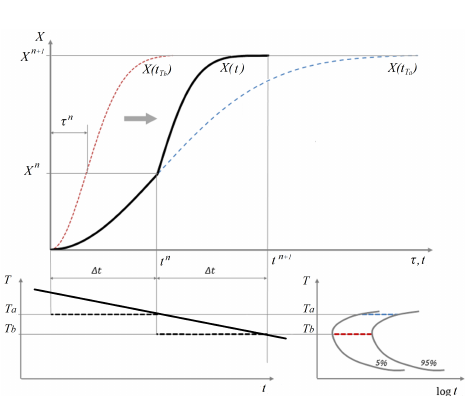
Figure 2: Example of Additivity Rule for 2 isothermal steps. De(cid:133)nition of the evolution of phase Figure 2. Example of Additivity Rule for 2 isothermal steps. Definition of the evolution of phase fraction X as the sum of the contributions of di⁄erent sets of k,p parameters extracted from the TTT curves. fraction X as the sum of the contributions of different sets of k,p parameters extracted from the TTT (Temperature-Time-Transformation)